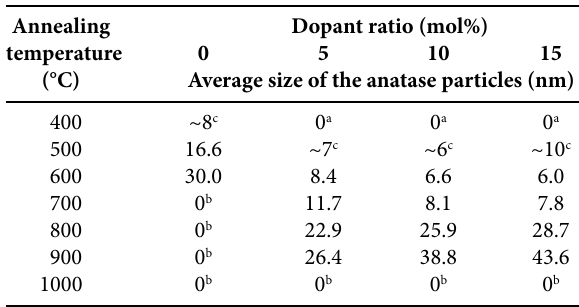
Table 1. Average size of the anatase particles in powders with differ- ent annealing temperatures and dopant